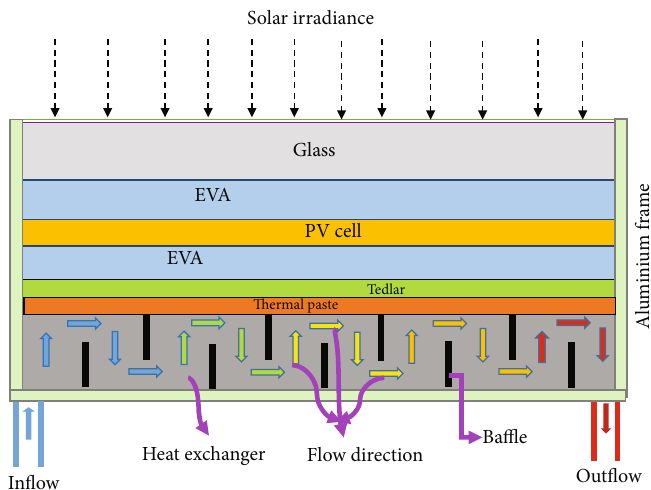
Figure 1: Two-dimensional view of the PVT system